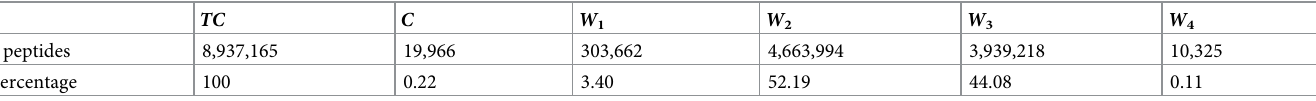
Table 1. Number and percentage of unique peptides of Trypanosoma cruzi ( TC ) are reported together with the partition in disjoint classes C , W 1 , W 2 , W 3 and W 4 .